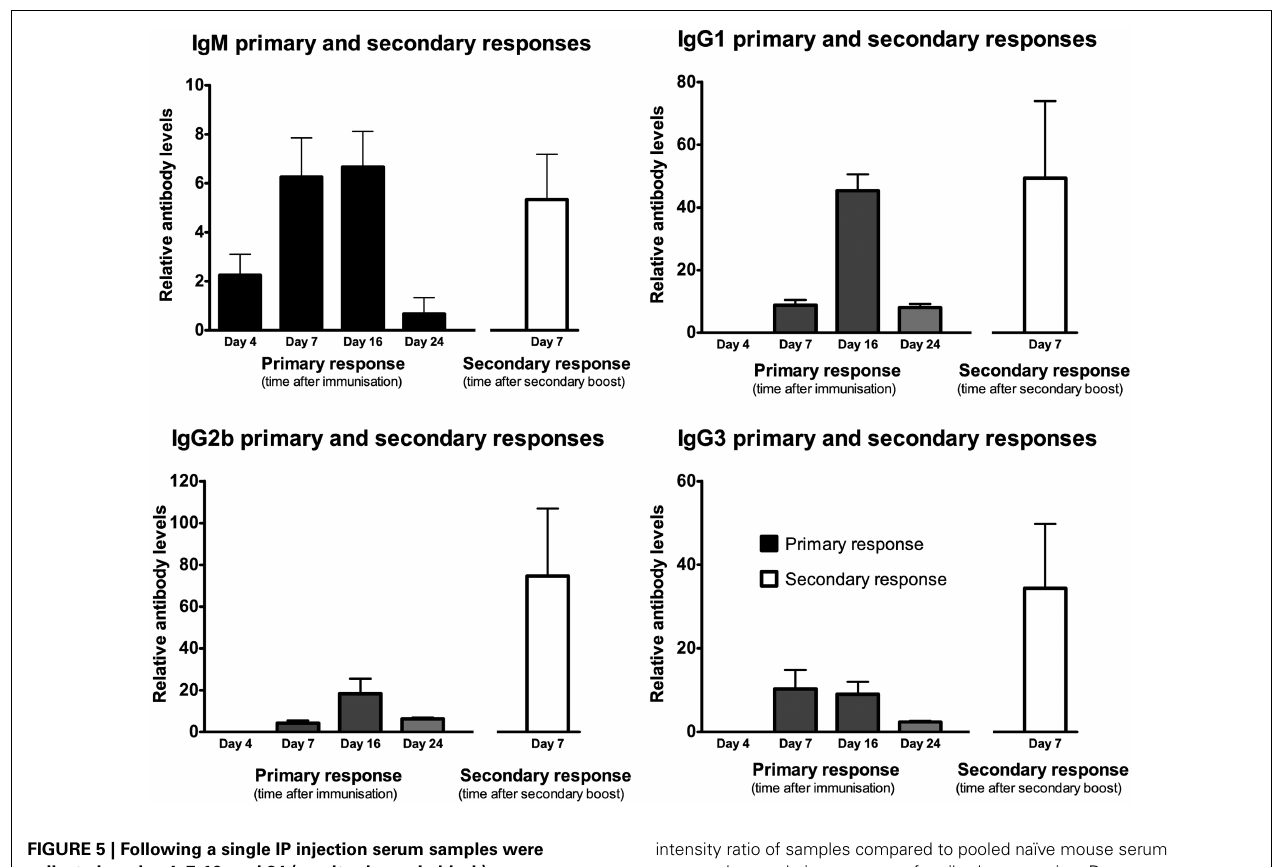
FIGURE 5 | Following a single IP injection serum samples were collected on day 4, 7, 16, and 24 (results shown in black) . Secondary immunization occurred on day 95 and serum was collected 7days later (results shown in white). Mean fluorescence